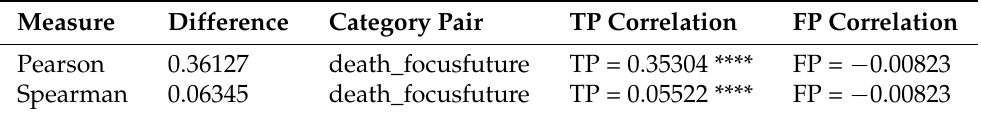
Table 45. Death and Focusfuture in